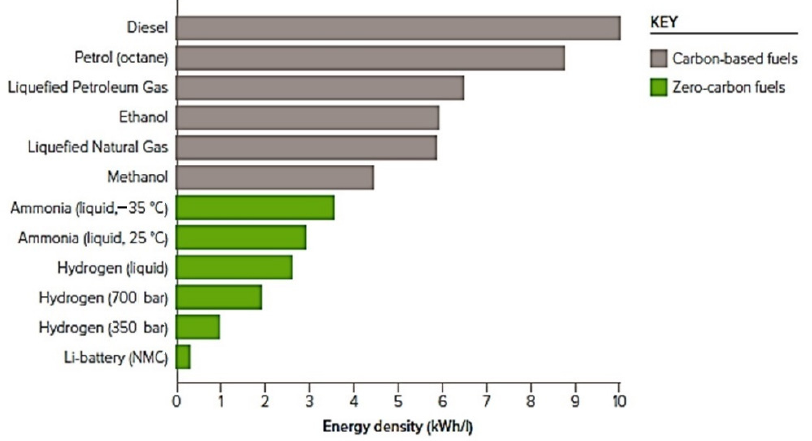
Figure 10. Comparison of the energy density of ammonia and hydrogen with carbon-based fuels. Reprinted with permission [69].